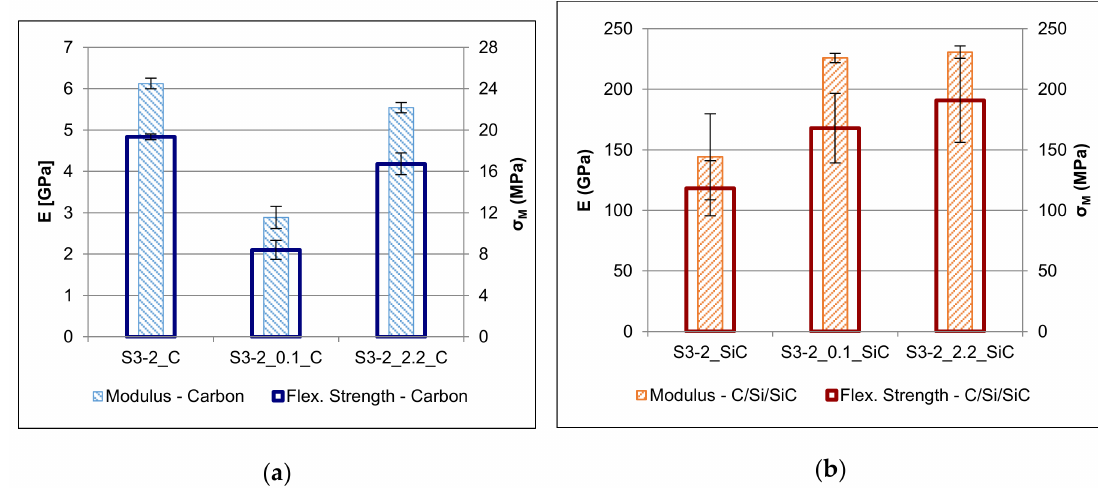
Figure 10. Flexural modulus ( E ) and strength ( σ M ) of the porous carbon specimens ( a ) and of the C / Si / SiC ceramics ( b